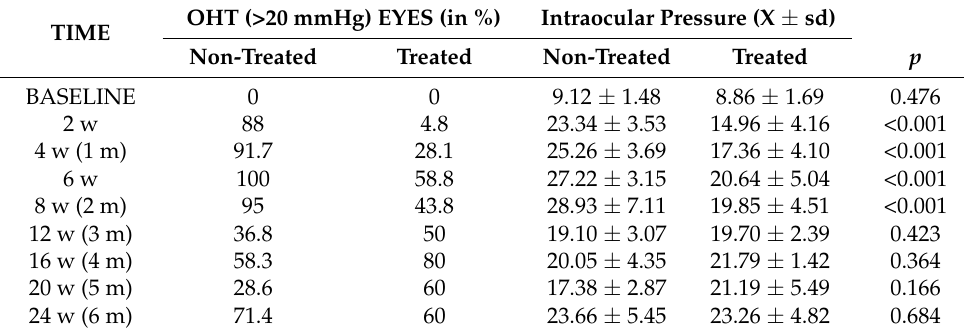
Table 1. Effect of BRI/LAP IF on intraocular